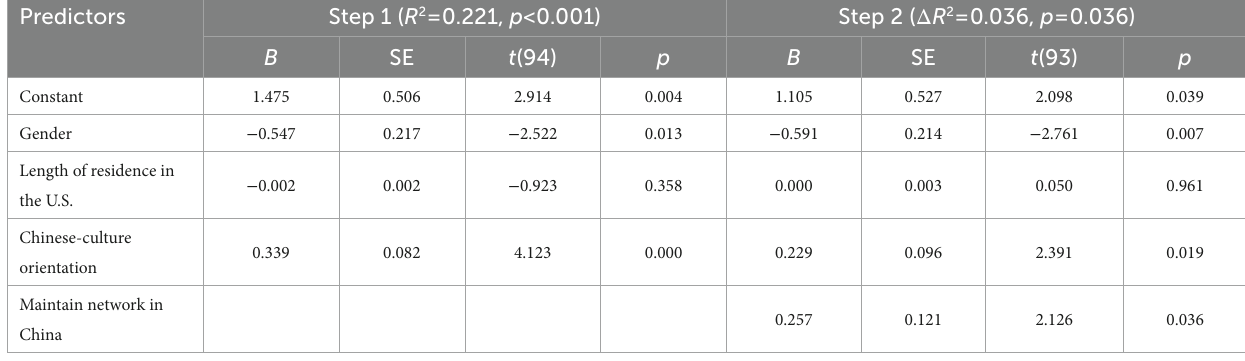
TABLE 4 Results of hierarchical linear regression predicting distant emotional support-seeking in Study 2.